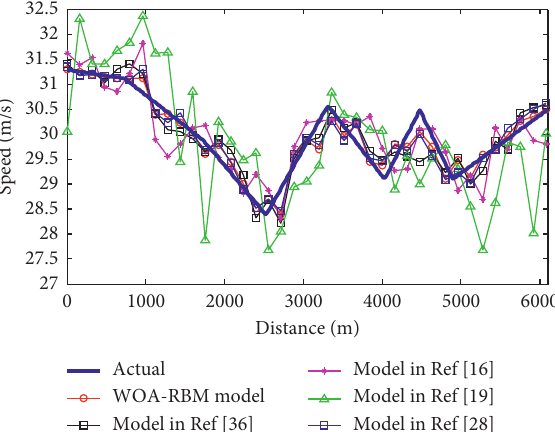
Figure 14: Different driver behavior model predictions.